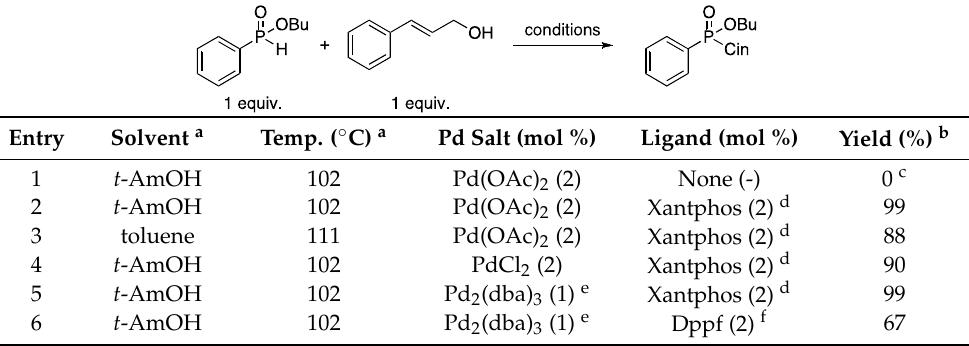
Table 1. Test reaction between butyl phenyl- H -phosphinate and cinnamyl alcohol.